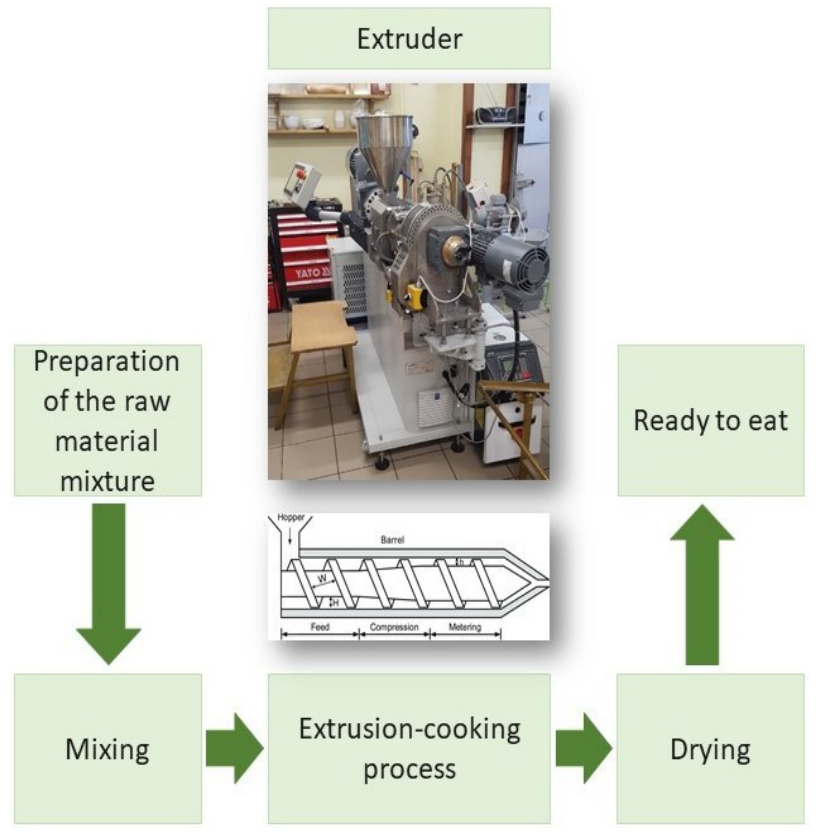
Figure 3. Diagram of the snack production process using extrusion-cooking .